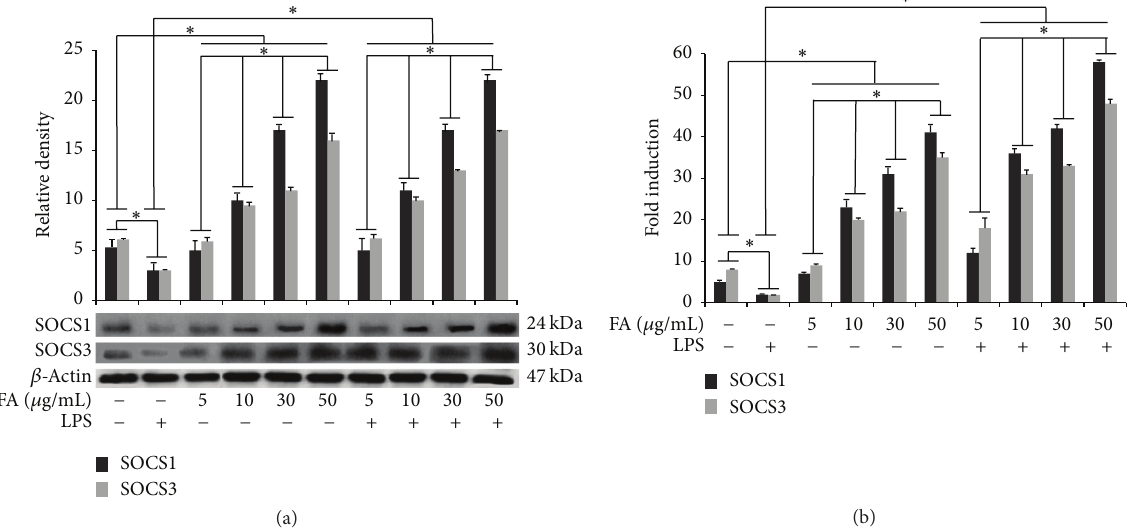
Figure 6: Modulation of SOCS proteins in BV-2 treated with folic acid. (a) Cells were treated with the indicated doses of folic acid (5, 10, 30, and 50 𝜇 g/mL) for 1h before LPS treatment. Total cell lysates were prepared for western blot analysis for the content of SOCS1 and SOCS3 in BV-2 cells. Protein levels were determined by measuring immunoblot band intensities by scanning densitometry. (b) mRNA expression determined by real-time RT-PCR. BV-2 microglial cells were incubated for 6h with LPS alone or after 1h of pretreatment with different amounts of folates. Data represent the means ± S.D. of five separate experiments. ∗ 𝑝 < 0.05